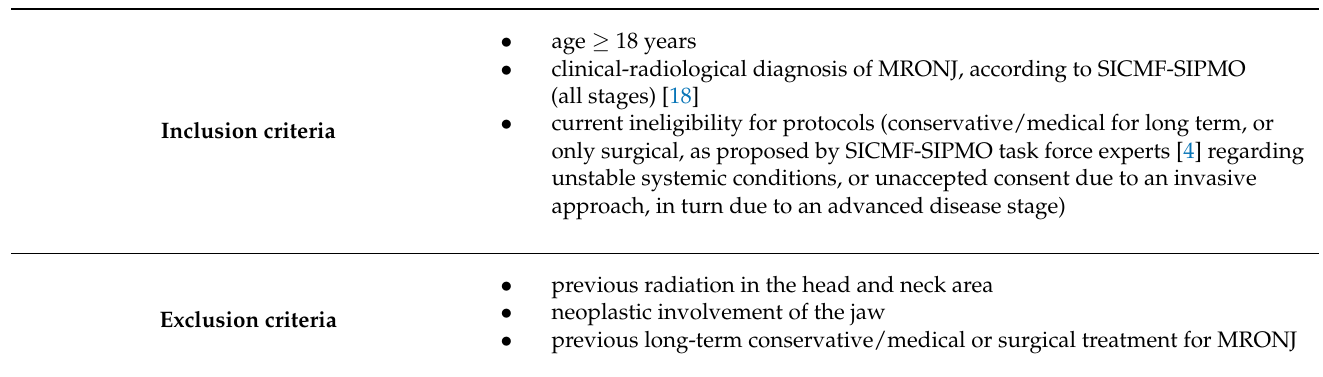
Table 1. Inclusion and exclusion